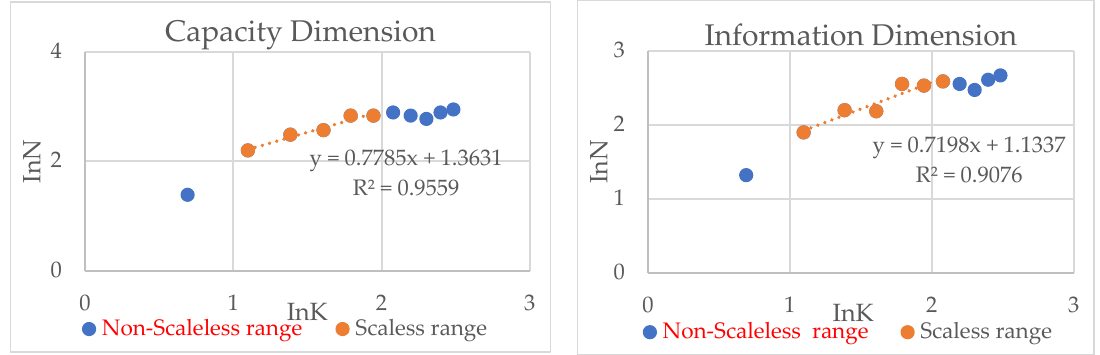
Figure 5. The log–log plot for the grid dimension of the Fuzhou park system.